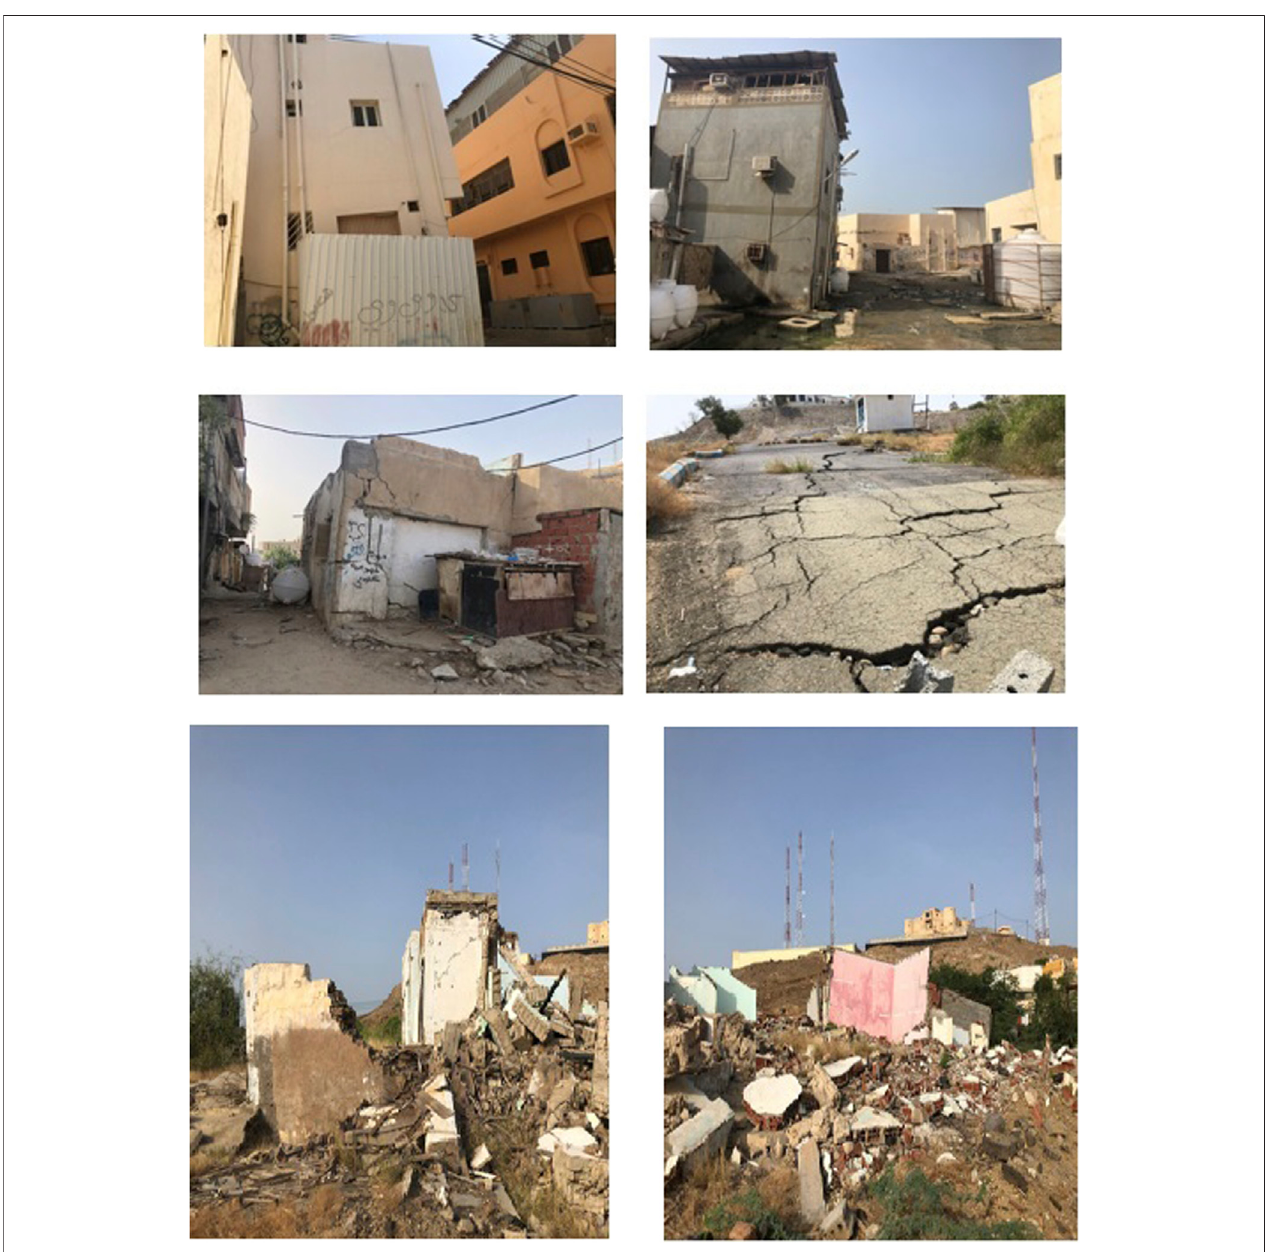
FIGURE 8 | Examples of the damages caused by the salt